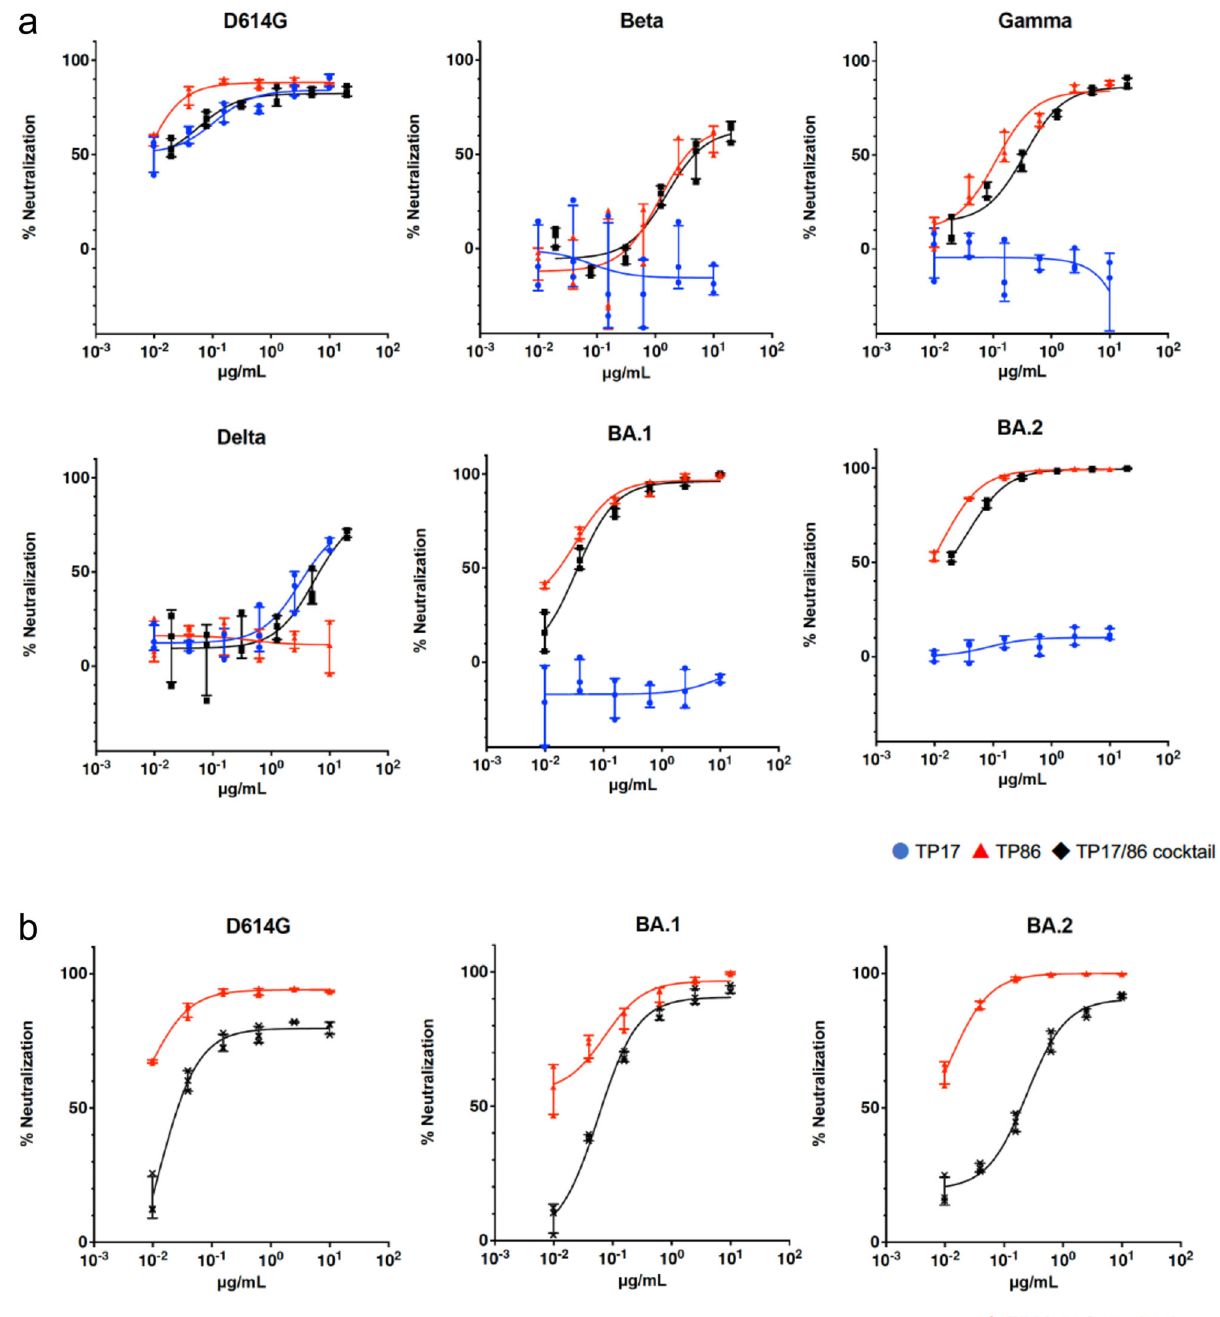
Fig. 1 Neutralization of SARS-COV-2 VOCs by trimerized nanobodies. a Neutralization curves of the indicated SARS-COV-2 variants in HOS-ACE2- TMPRSS2 cells by trimerized nanobodies, TP17, TP86 and the TP17/86 cocktail. b Neutralization curves of the indicated SARS-COV-2 variants by TP86 and sotrovimab. Data are presented as the average ± SD ( n =